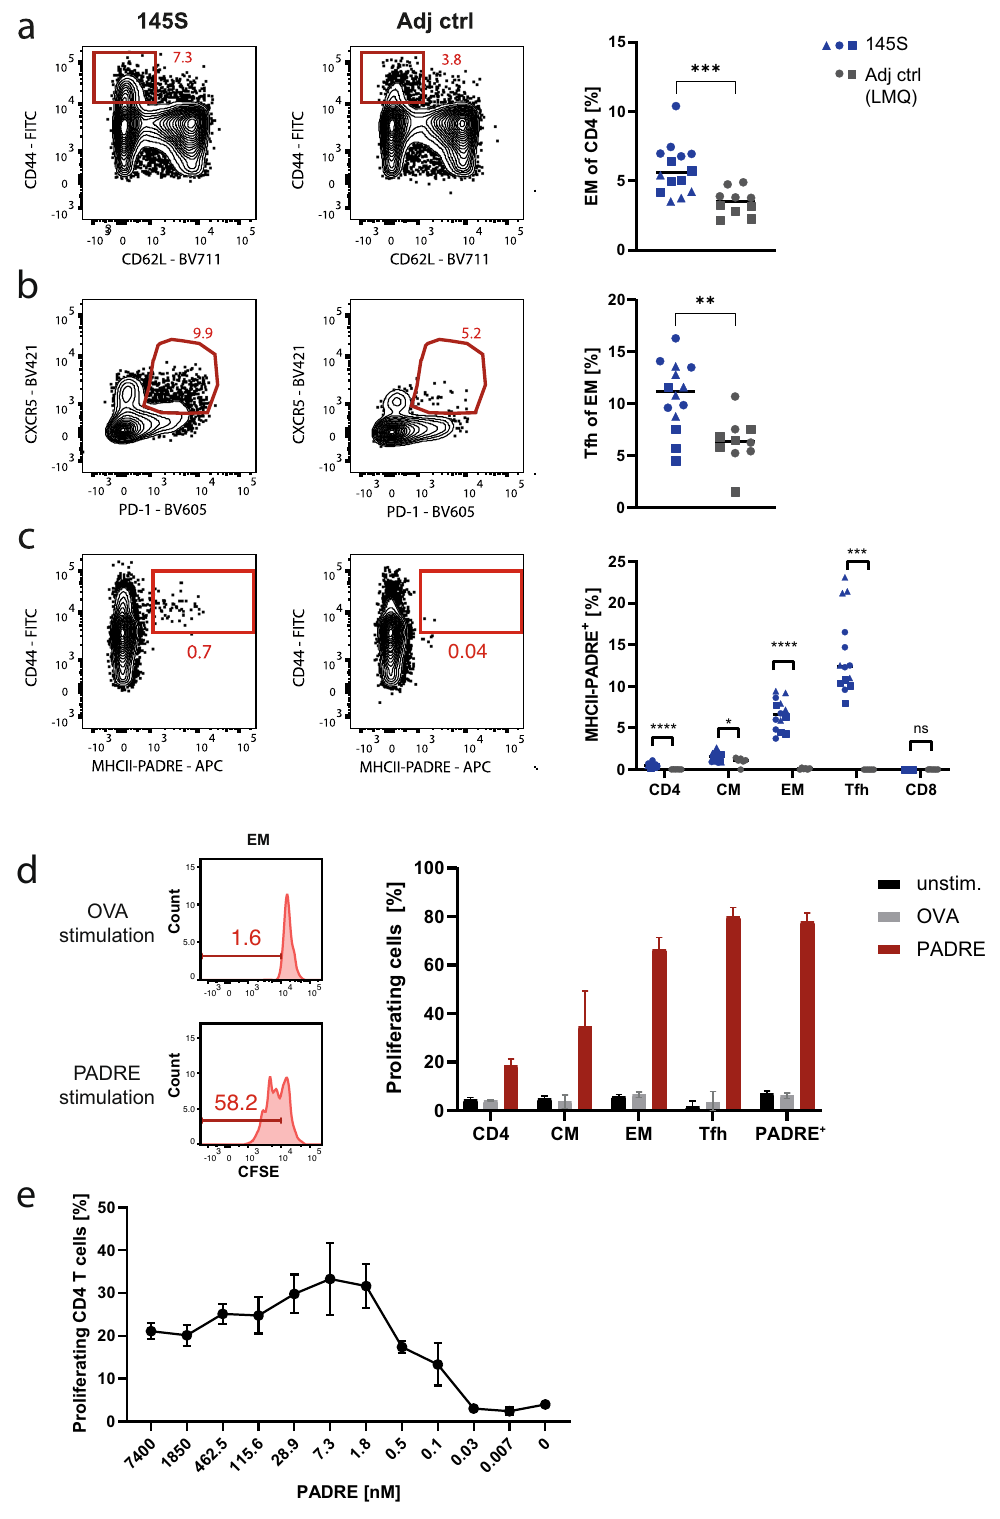
For ef fi cient presentation to the immune system, we fused the PfCSP component to the N-terminus of H. pylori apoferritin, exposing the target B cell epitopes on the exterior of the nanoparticle. H. pylori apoferritin shows only 20% sequence similarity to human ferritin and no cross-reactivity has